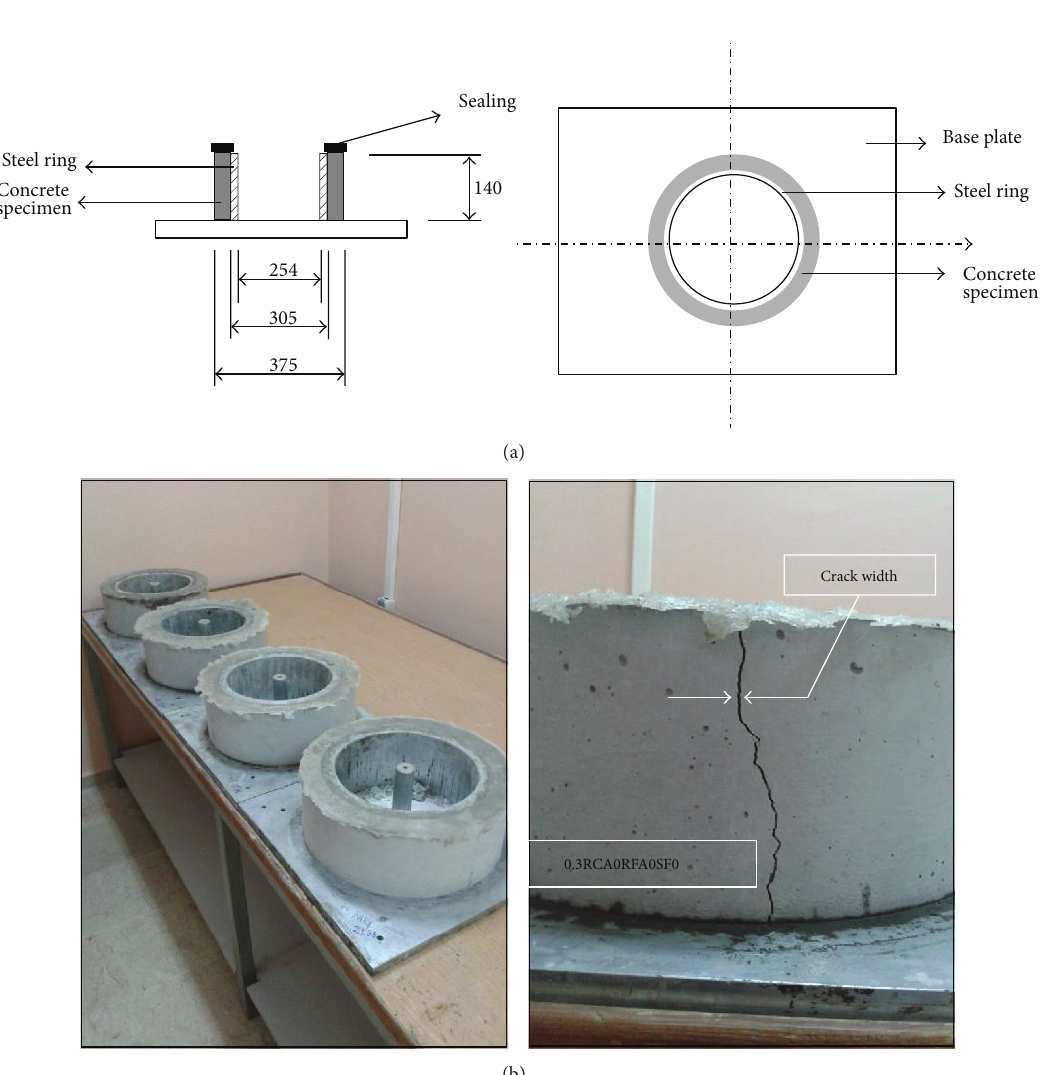
Figure 7: Restrained shrinkage cracking test: (a) dimensions of a restrained shrinkage ring specimen (in mm) and (b) photographic view of a cracked ring specimen in control mix